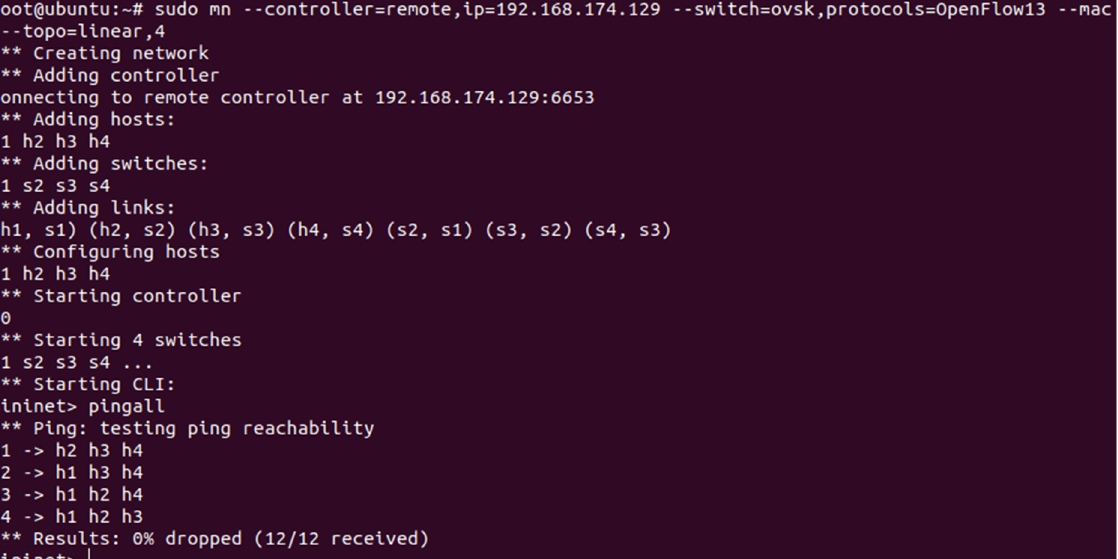
Figure 24. Diagrammatically create custom linear network topology on ODL DLUX con ‐ sole. Visit your URL as an alternative and use the admin/admin credentials to log into the DLUX interface. Your IP address must be entered in the space given. Following the exe ‐ cution of the code, only switches are visible when you click the upload button on the DLUX console. After running the pingall command, the host will establish a connection, and your network will be ready to process data transfers. An ODL DLUX ‐ based Applica ‐ tion that produces and renders a straightforward user interface based on YANG models fed into ODL and aimed to simplify and facilitate application development and testing. Yang visualizer and user interface is a data model language for configuration, state infor ‐ mation, network topology (as shown in Figure 25), actions, oxm ‐ container (as shown in Figure 26), and notifications for network elements and services. It is being used to specify additional data interfaces in Open Daylight and Netconf, an IETF ‐ standard network ad ‐ ministration protocol.